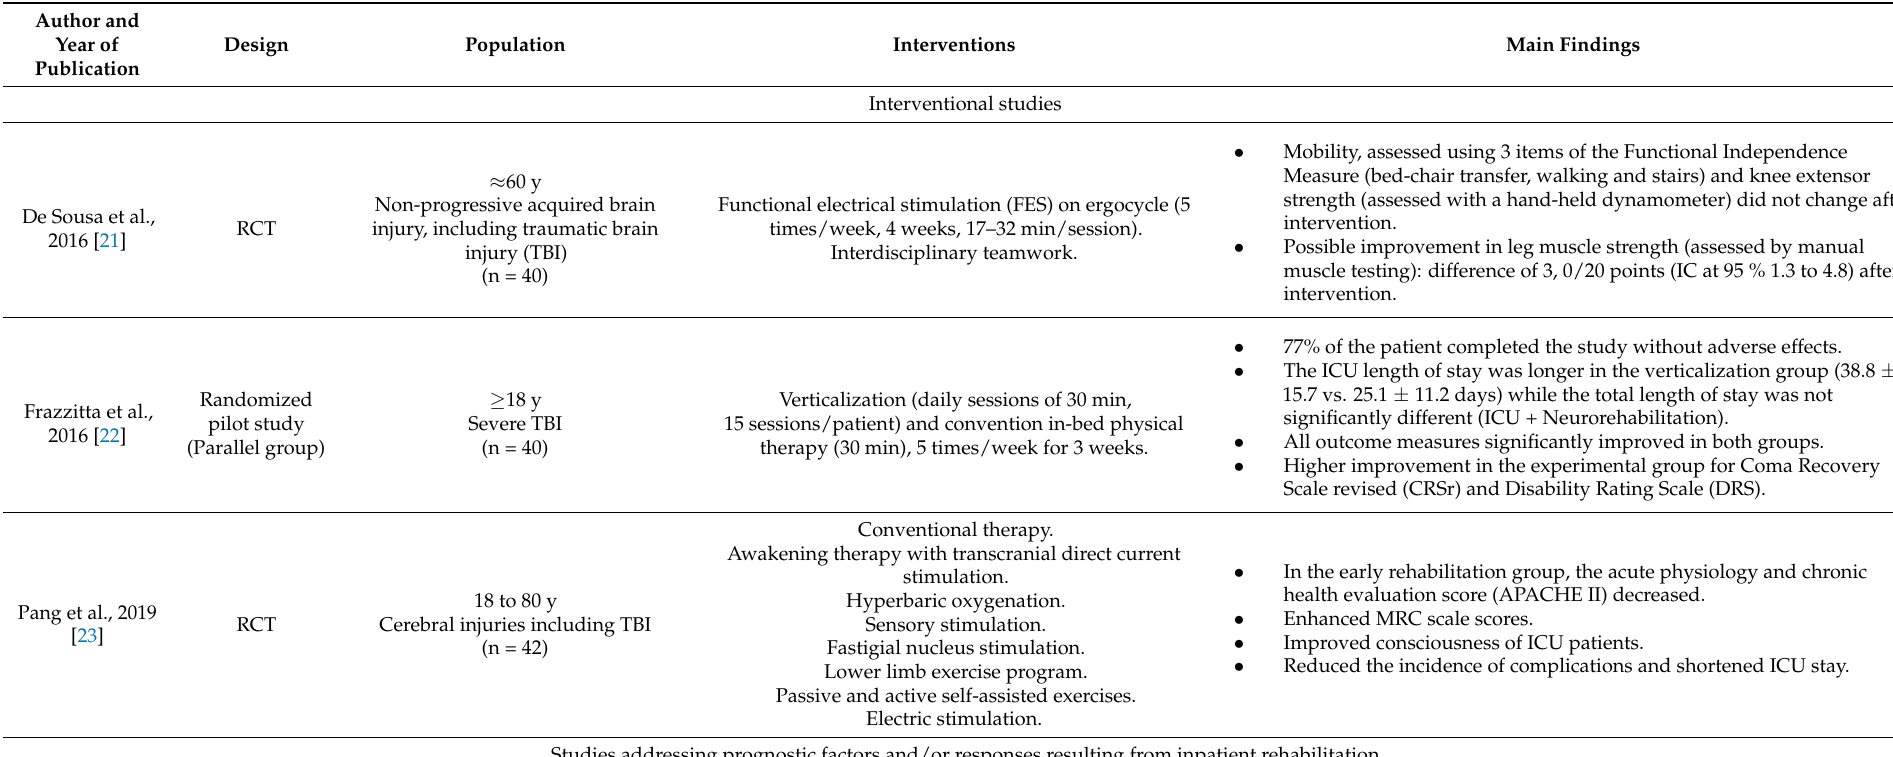
Table 2. Summary description of the studies included in the